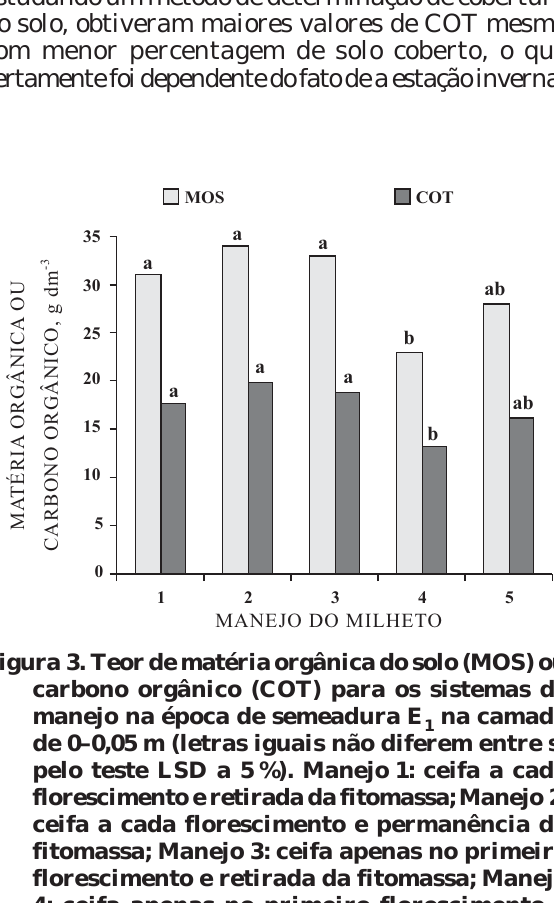
Figura 4. Teor de matéria orgânica do solo (MOS) ou carbono orgânico (COT) para os sistemas de manejo na época de semeadura E na camada 3 de 0–0,05 m (letras iguais não diferem entre si pelo teste LSD a 5 %). Manejo 1: ceifa a cada florescimento e retirada da fitomassa; Manejo 2: ceifa a cada florescimento e permanência da fitomassa; Manejo 3: ceifa apenas no primeiro florescimento e retirada da fitomassa; Manejo 4: ceifa apenas no primeiro florescimento e permanência da fitomassa; Manejo 5: livre crescimento, sem